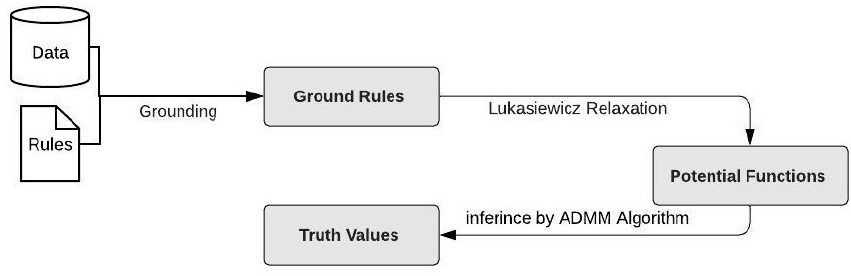
Figure 1. How PSL assigned truth values for the random